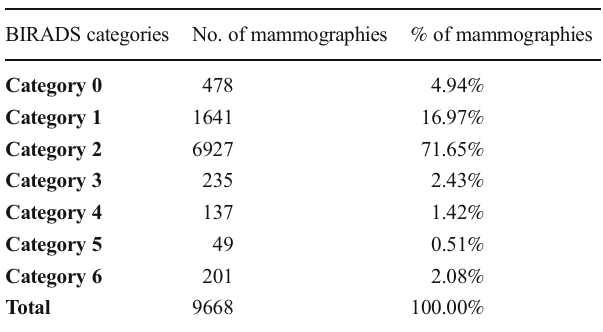
Number of mammographies and their distribution percentages in the BIRADS categories Mammography distribution into the BIRADS categories in our